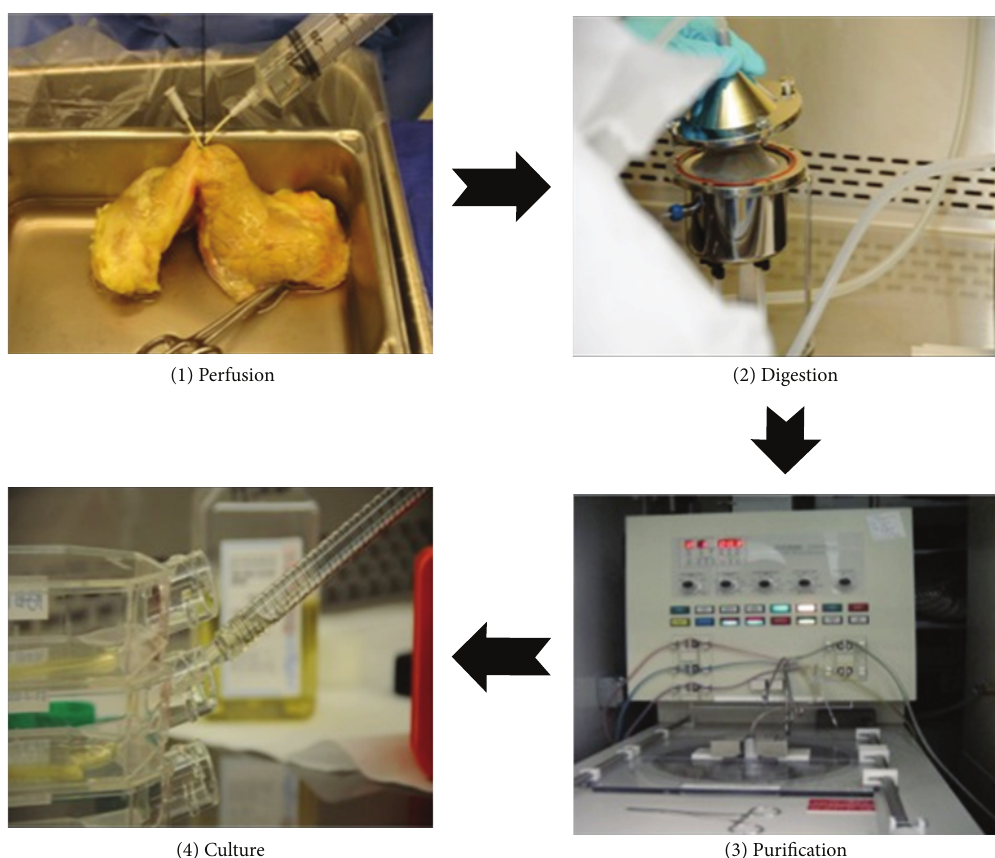
Figure 1: Human islet isolation procedure. (1) Pancreas perfused with enzymatic solution; (2) pancreatic tissue digested in Ricordi isolation chamber; (3) digested tissue purified in COBE 2991 cell separator; (4) purified islets cultured at 37 ∘ C/5% CO 2